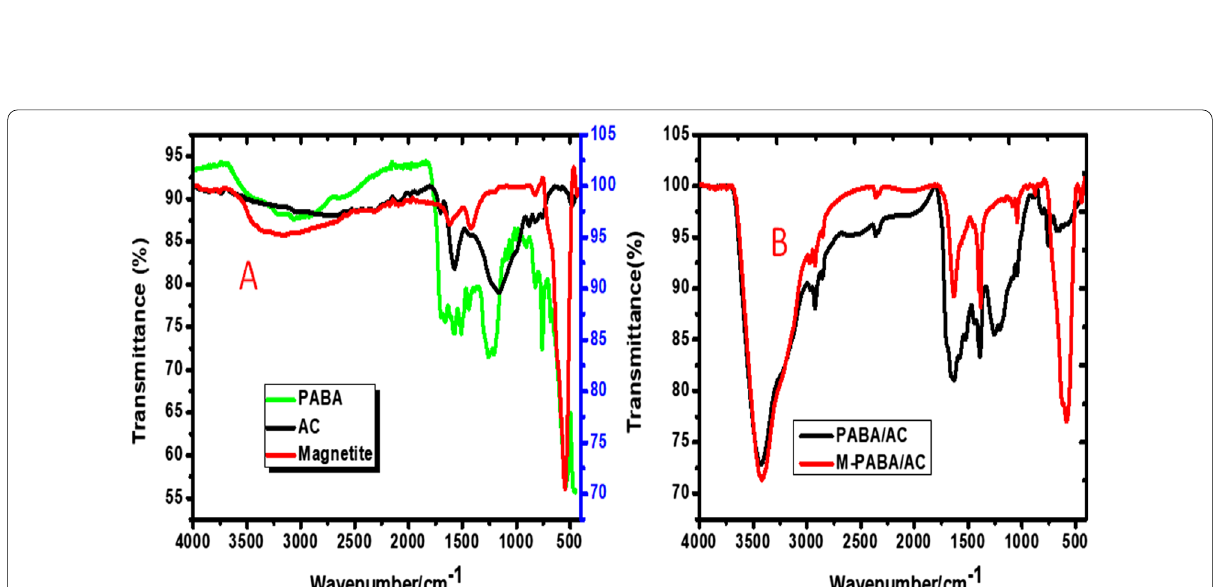
Fig. 2 FTIR spectra indicating the functional groups and characteristic bonds of the as-synthesized materials. Magnetite refers to Fe 3 O 4